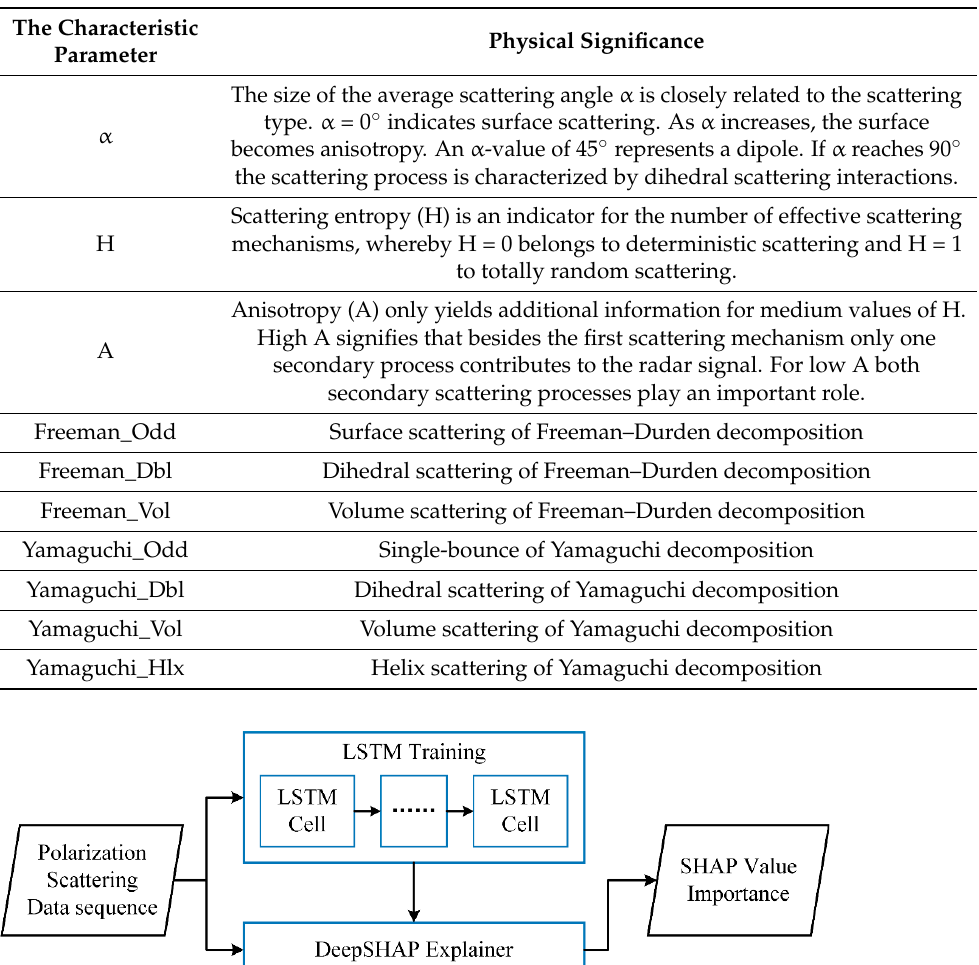
Table 2. Characteristic parameters of target decomposition and their physical significance.